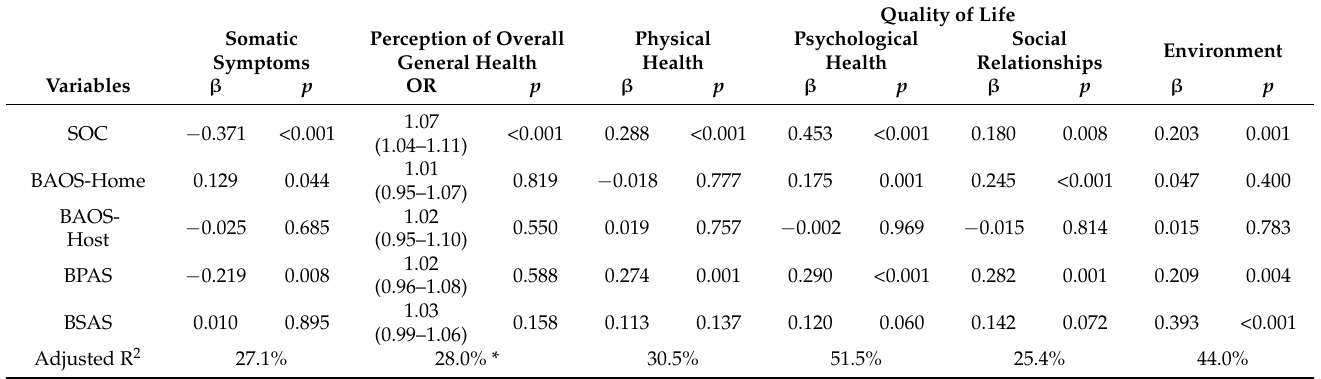
Table 6. Associations between perceived health, quality of life, and predictor variables—unadjusted linear regression model.